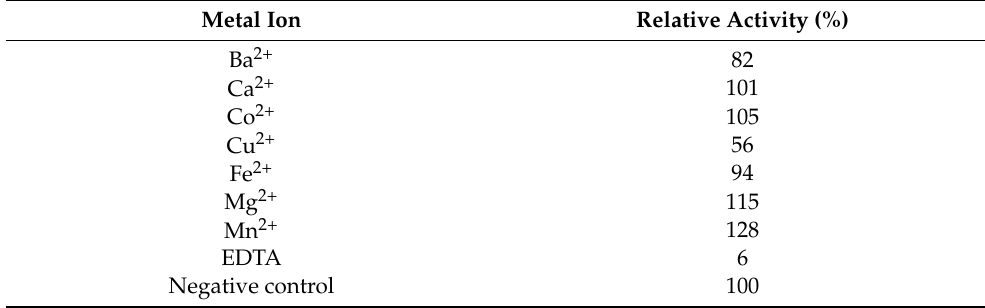
Table 1. Effects of metal ions on the activity of L -arabinose isomerase from K. pneumoniae .